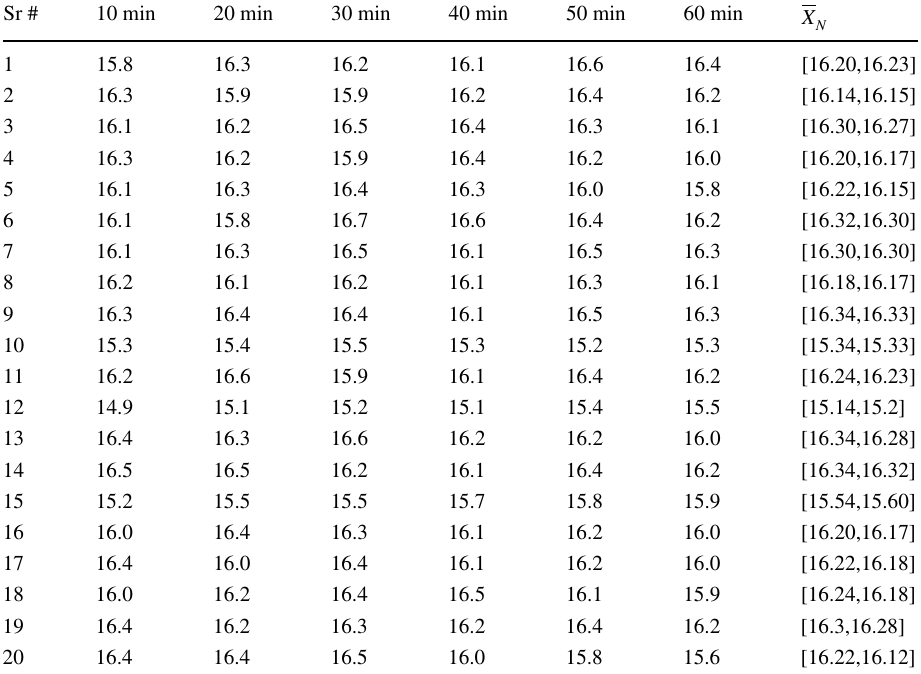
Table 6 Real data of 20 samples of fertilizer production, taken from